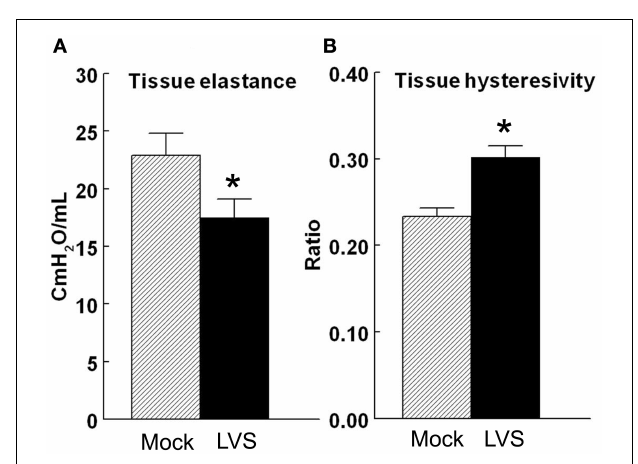
FIGURE 4 | Effects of F. tularensis LVS infection on lung tissue functions. Lung tissue function (elastance and hysteresivity) was determined using 5-day post challenge animals ( n = 5/group) as described under Section “Materials and Methods.” (A) Tissue Elastance; (B) Tissue Hysteresivity * = p <